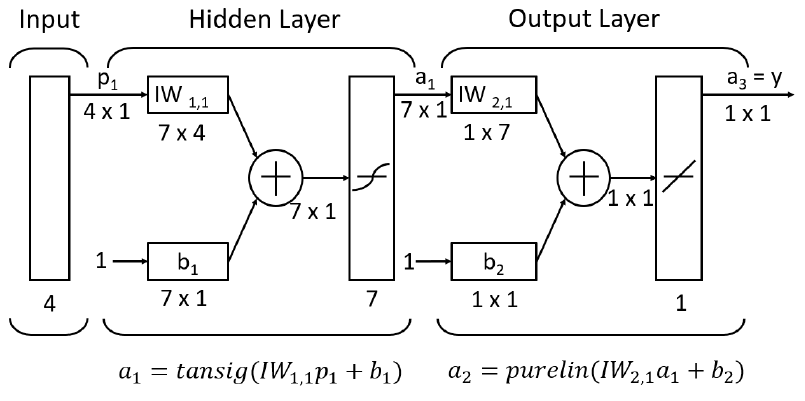
Figure 16. Multilayer networks (4-7-1).